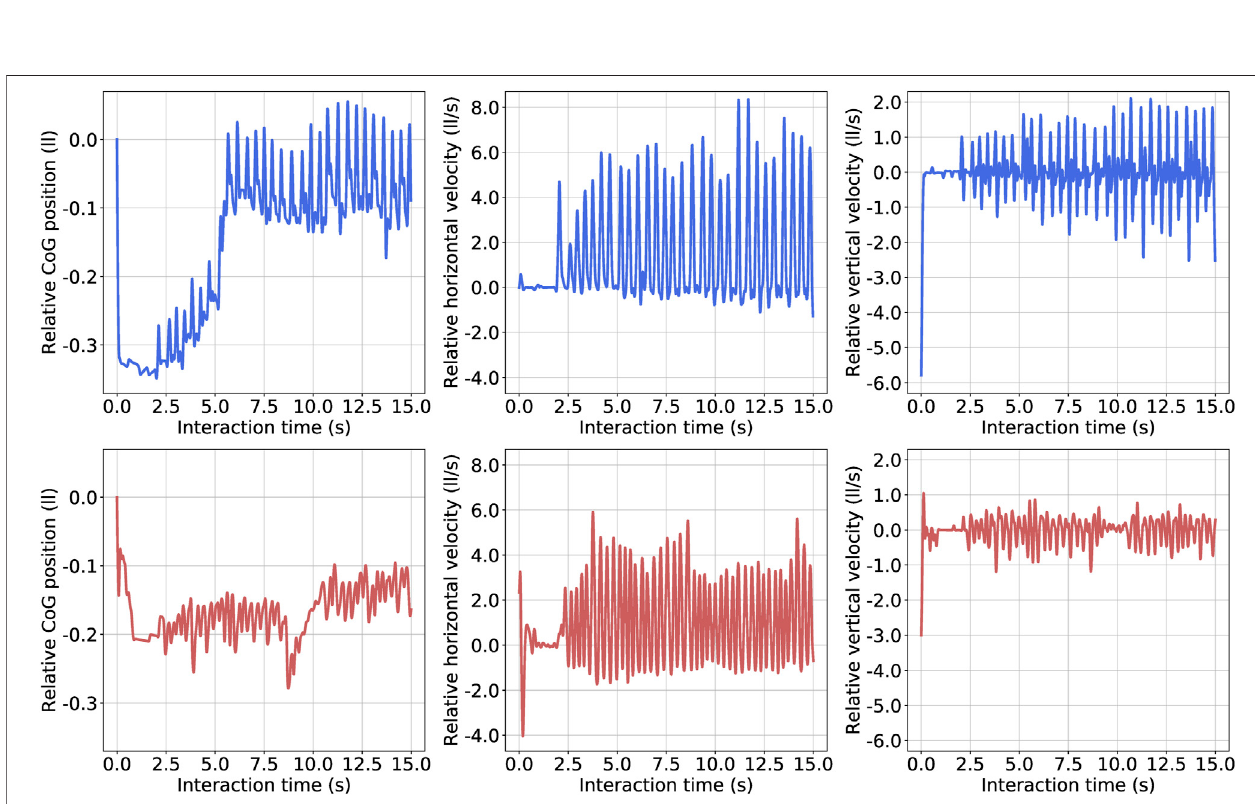
FIGURE 6 | Gait analysis of best biped and best tripod. We pre-processed all data and divided it by the leg length to eliminate the inherent advantage of the biped creature with longer leg length than the tripod creature. The values have oscillations due to characteristics of the virtual model and the data captured at the center of the body.Abouttheunit, ll representstheleglength,and ll / s representstheleglengthpersecond.TheupperthreebluelinesaretherelativeCenterofGravity(CoG)position, relative horizontal and vertical velocities of the best biped while the lower red lines are for the best tripod. Here, the relative CoG position is calculated based on the original CoG ofthe biped and tripod from the beginning ofthe simulation. For instance, 0 relative CoG position means the position of center of gravity at the beginning of the simulation.